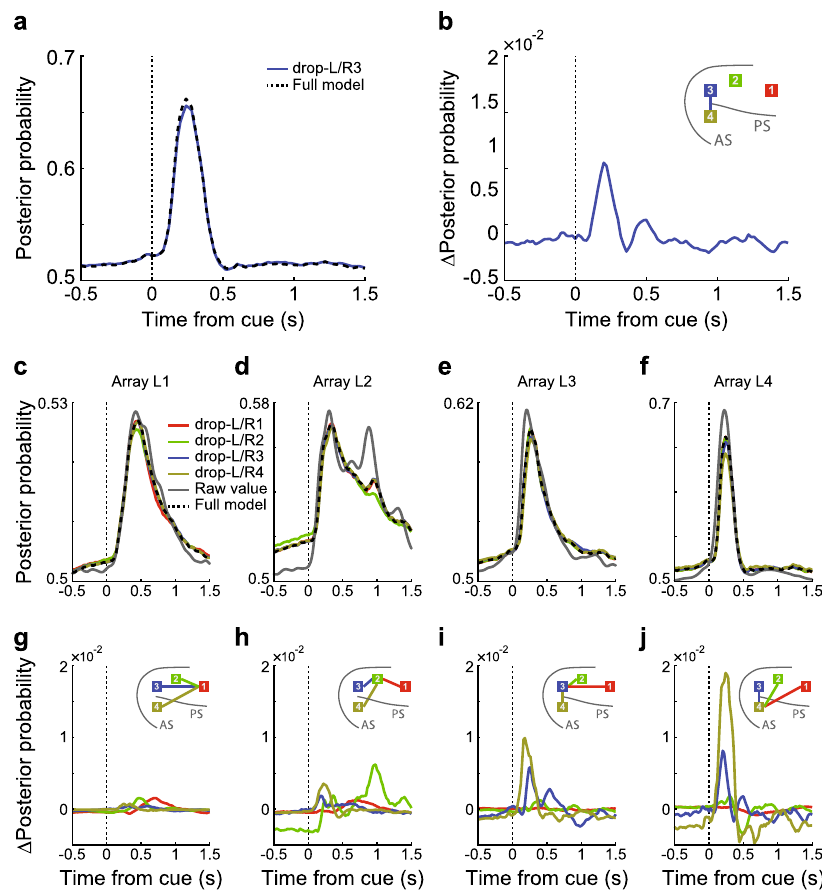
Fig. 5 Modeling example. An example of the posterior probability of the information-transfer model, predicting the decoding accuracy of action in Where blocks of array 1 ( c , g ), array 2 ( d , h ), array 3 ( e , i ), and array 4 ( f , j ) in the left hemisphere with input from all eight arrays. a The predictions of array L4 from the Full model and the drop-L/R3 Partial model. b The difference between the Full model and the drop-L/R3 Partial model. Inset: the colored line connects the dropped input array (indicated by the color of the line) and the output array. Here, array 3 as an input array, and array 4 as the output array. c – f The posterior probability of the raw value, the Full model, and the Partial models with the average effect of the arrays at the corresponding locations in the left and right hemispheres. g – j The difference of posterior probability between the Partial models and the Full model. Inset: the colored lines connect the dropped input (indicated by the lines ’ color) and the output